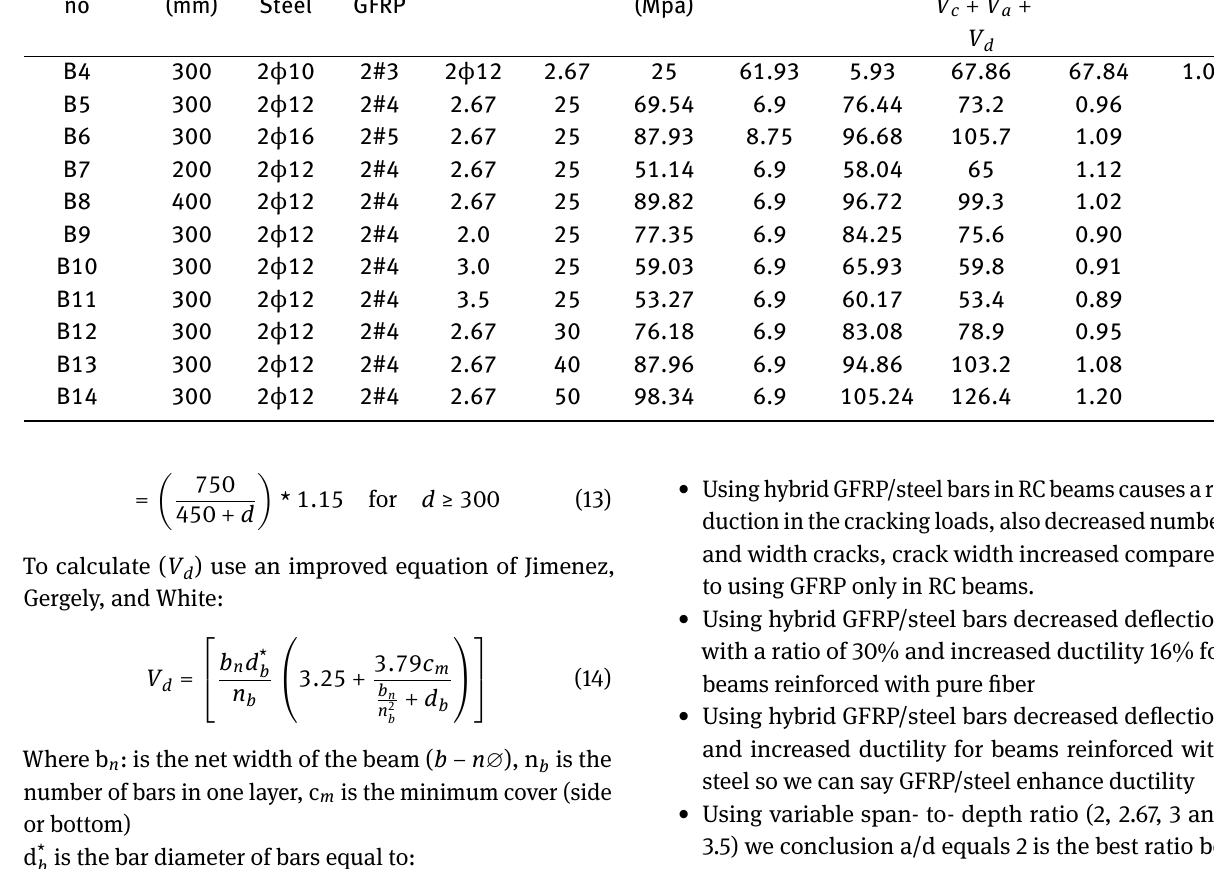
Table 8: The comparison between theoretical and experiential results